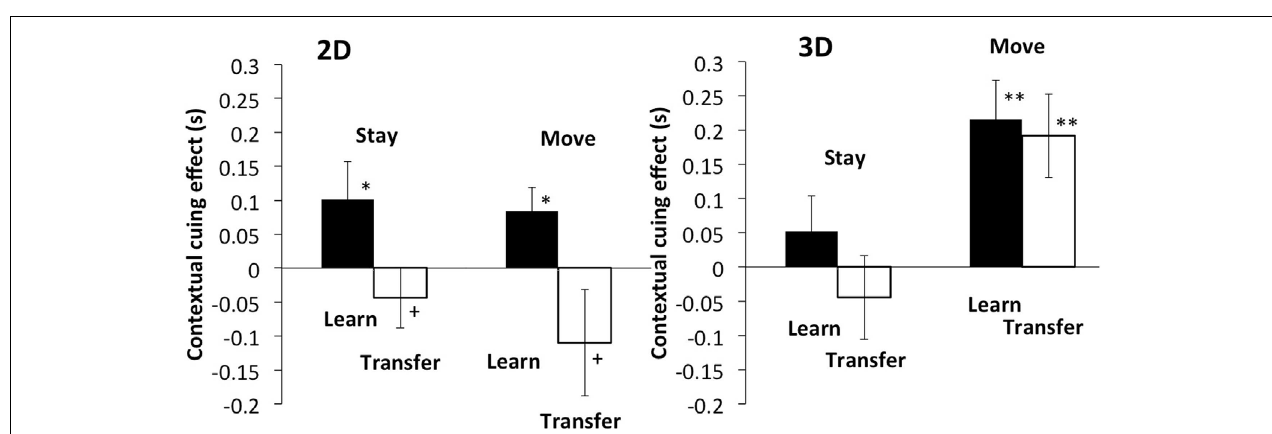
result of the last two epochs of the learning phase, and the white bar shows the result of the epochs of the transfer phase. Error bars represent standard error across